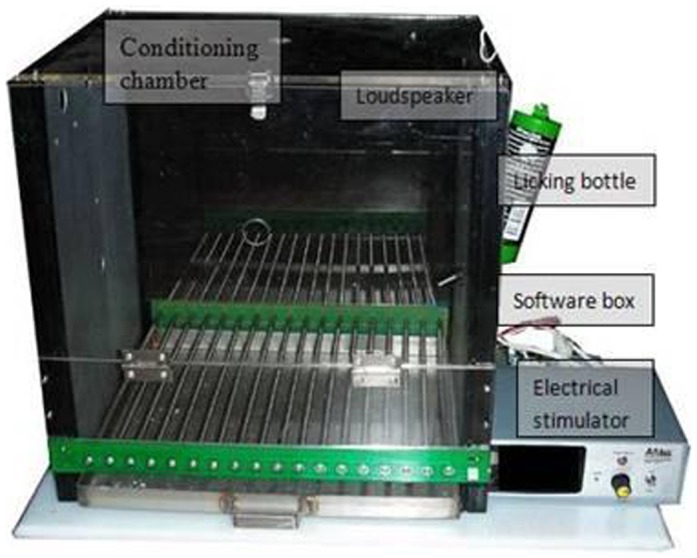
The operant behavioral system used in the study. It includes a conditioning chamber, a licking bottle, an electrical stimulator, and a behavioral software box. The loudspeaker is not shown in the picture.